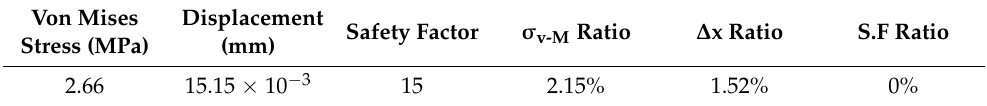
Table 2. Validation Results of the Previous